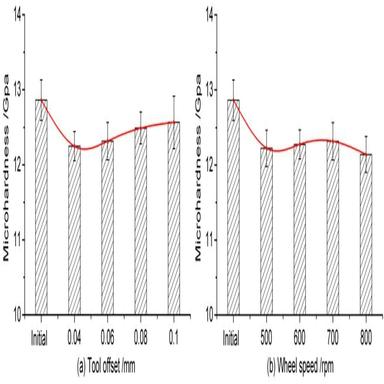
Micro-hardness measurement results of the samples before and after polishing under different tool offsets and wheel speeds.